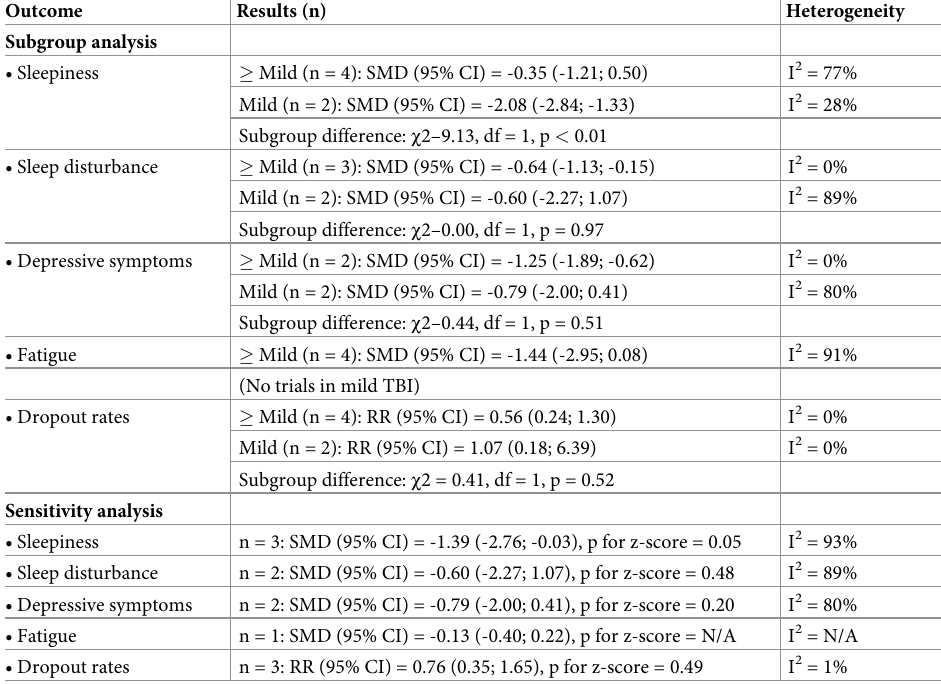
Table 2. Results of subgroup and sensitivity